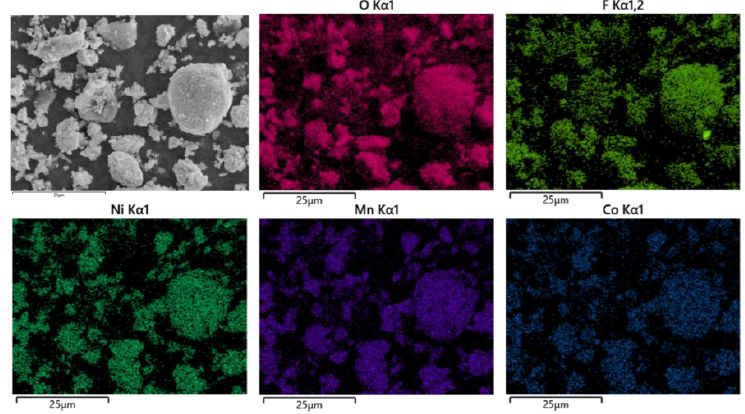
Figure 12. SEM of battery materials after pyrolysis at 200 °C.